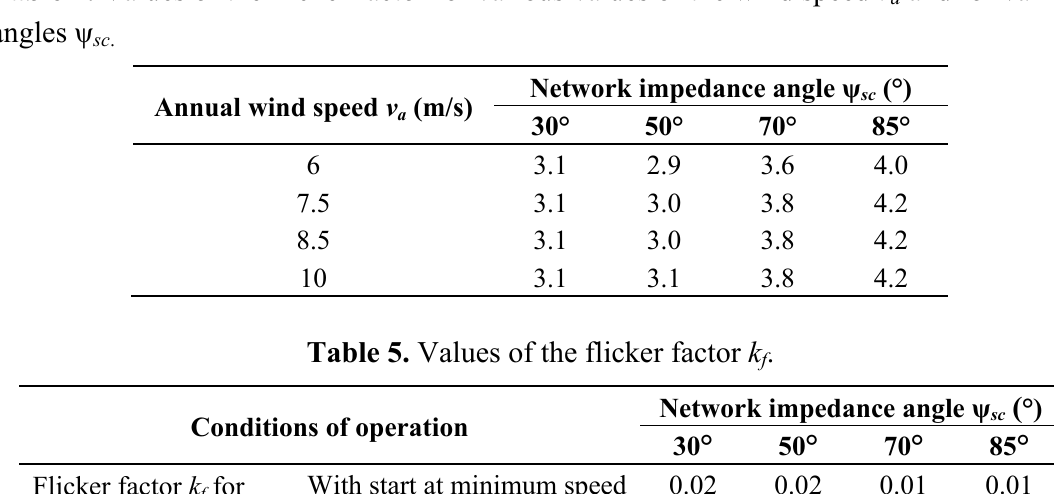
and for various a